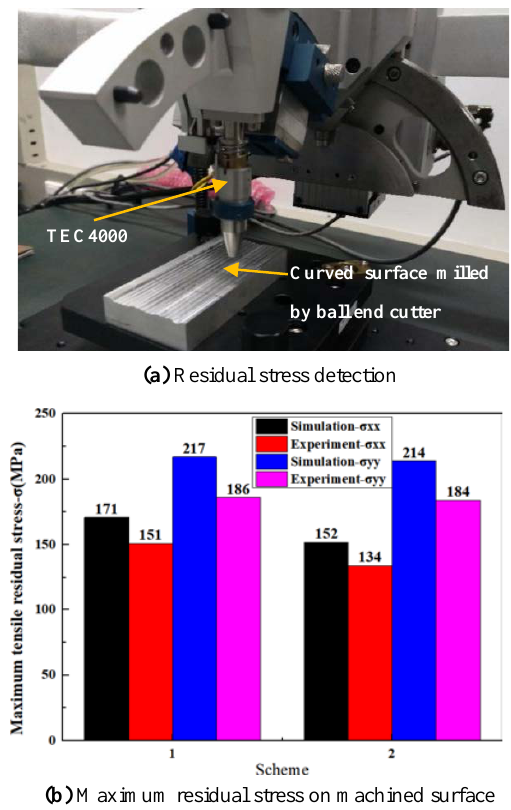
Fig. 3. Residual stress detection and comparison of residual stress on machined